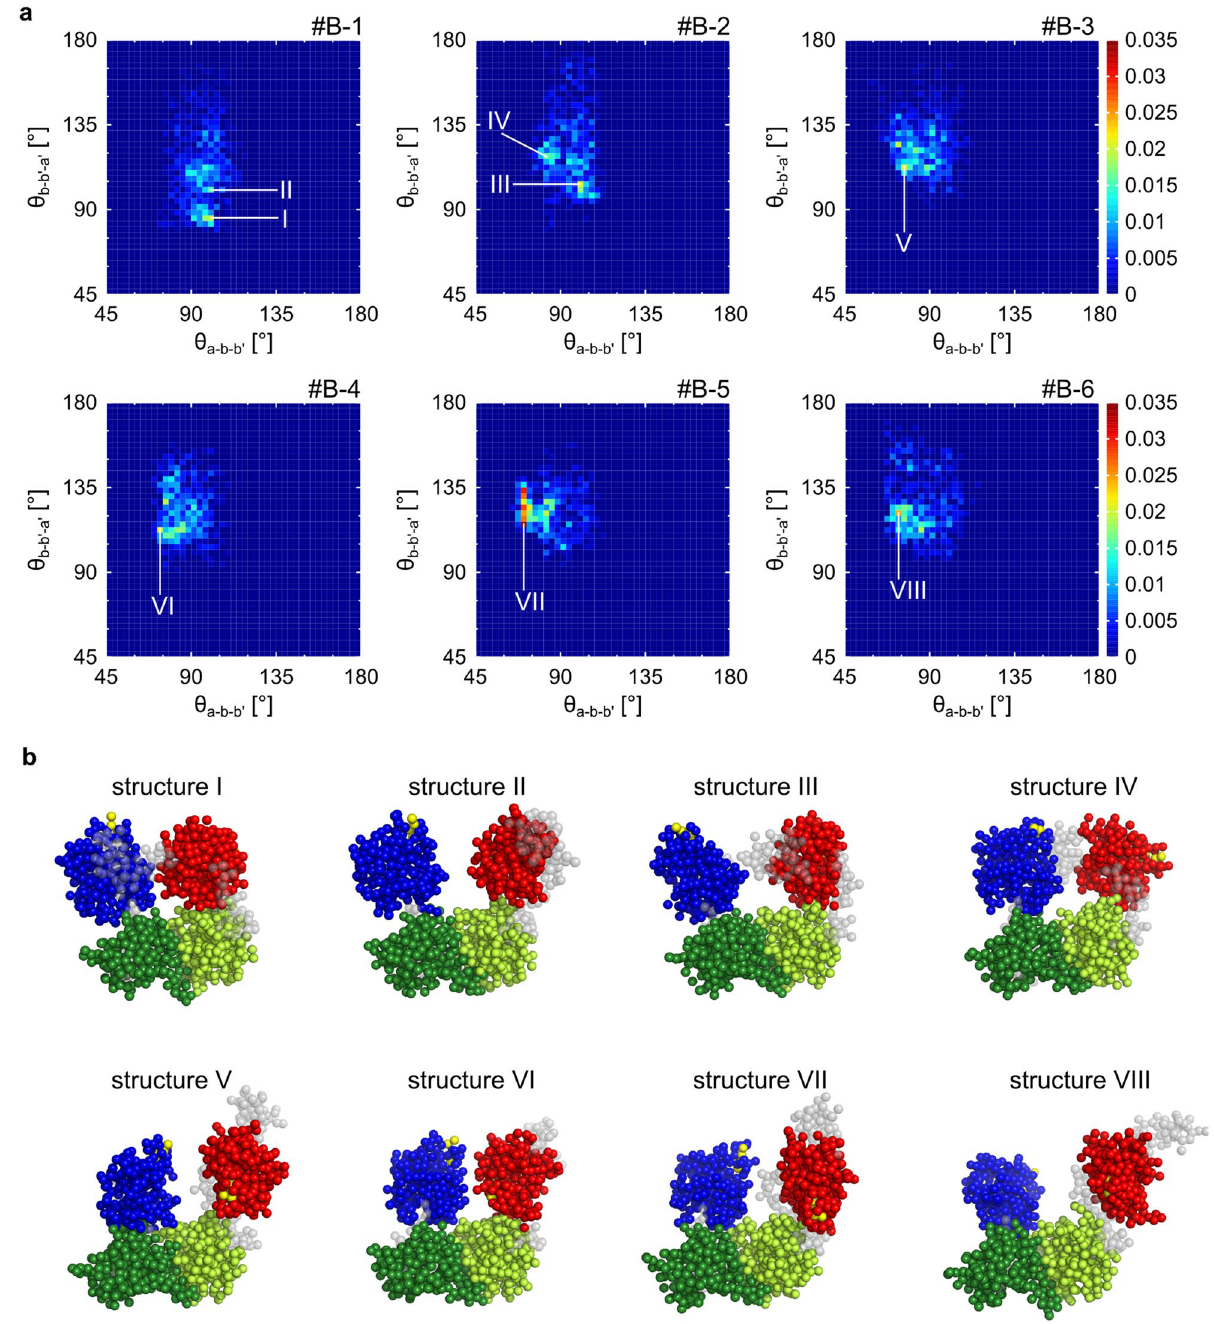
Figure 5. Structure of ER-60 in the clipped time series. ( a ) Domain conformations of ER-60 in the time series #B-1, #B-2, #B-3, #B-4, #B-5, and #B-6 are shown. The color in heatmaps show the appearance probability in the two-dimensional space. ( b ) Structures of ER-60 correspond to the I–VIII. The a domain is shown in blue, the b domain in green, the b ′ domain in yellowish green, and the a ′ domain in red. The other parts are gray. The reactive cysteines are